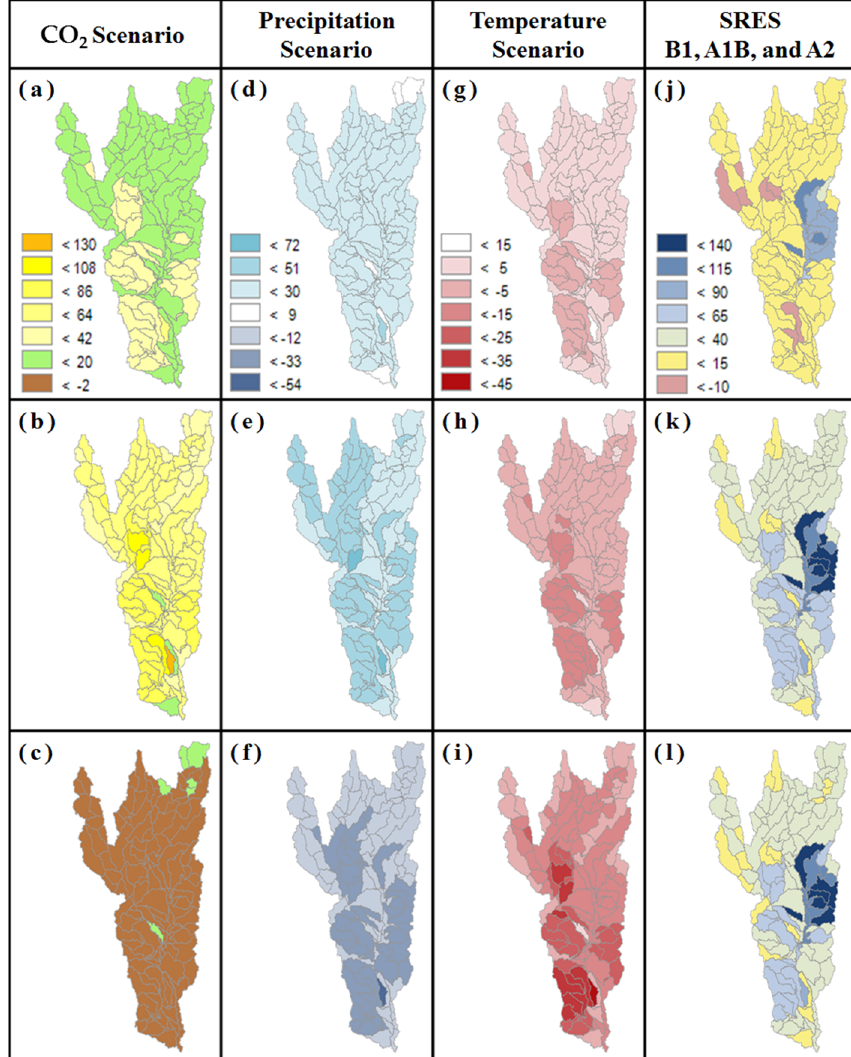
Figure 3. Spatial distributions of streamflow ratio under the climate sensitivity scenarios during the reference period (2003–2011) and SRES B1, A1B, and A2 (2051–2059). ( a – c ) CO 2 scenarios; ( d – f ) Precipitation scenarios; ( g – i ) Temperature scenarios; and ( j – l )